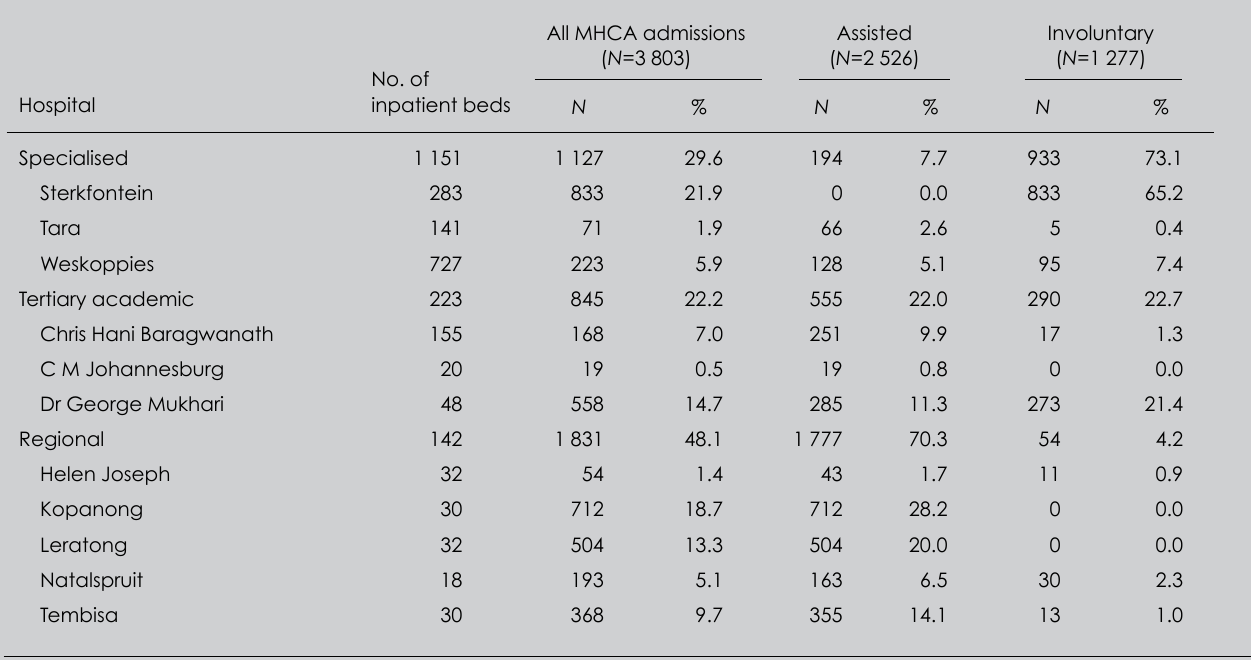
No. of inpatient